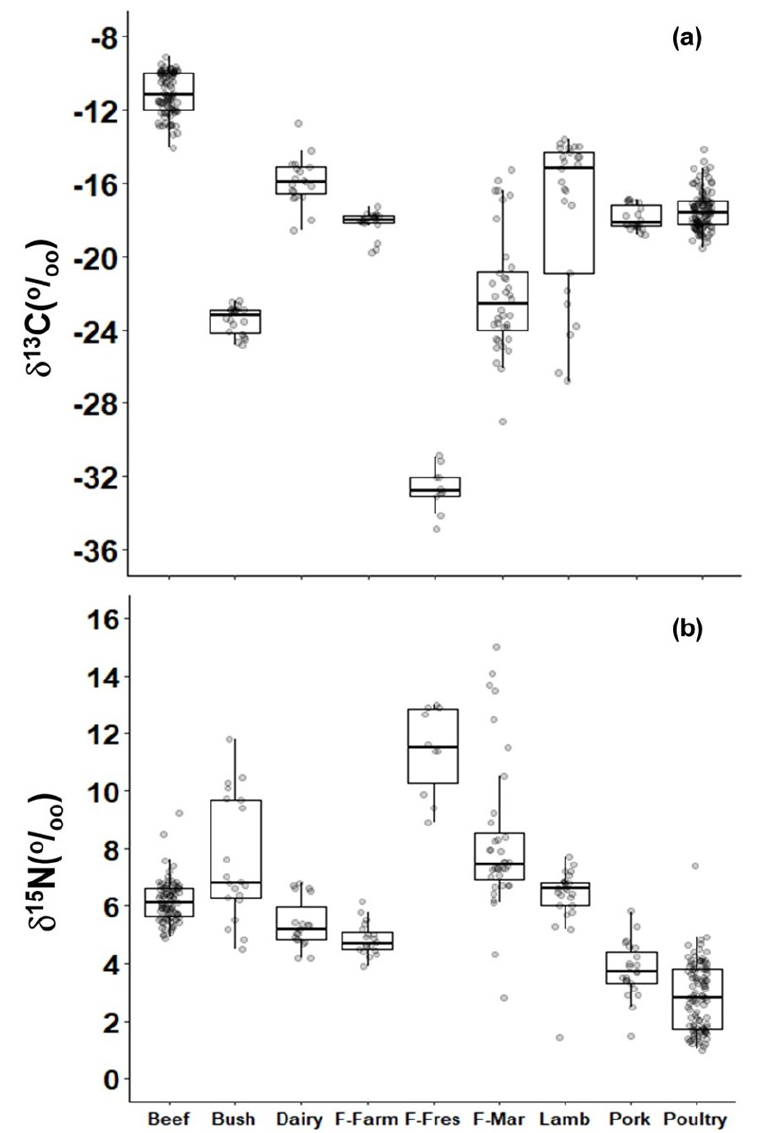
Figure 3. Box-whisker of δ 13 C ( a ) and δ 15 N ( b ) of raw meats used as food in Brazil grouped as follows: beef, bushmeat (Bush), farm-raised fish (F-Farm), freshwater fish (F-Fres), marine fish (F-Mar), dairy, lamb, pork, and poultry.